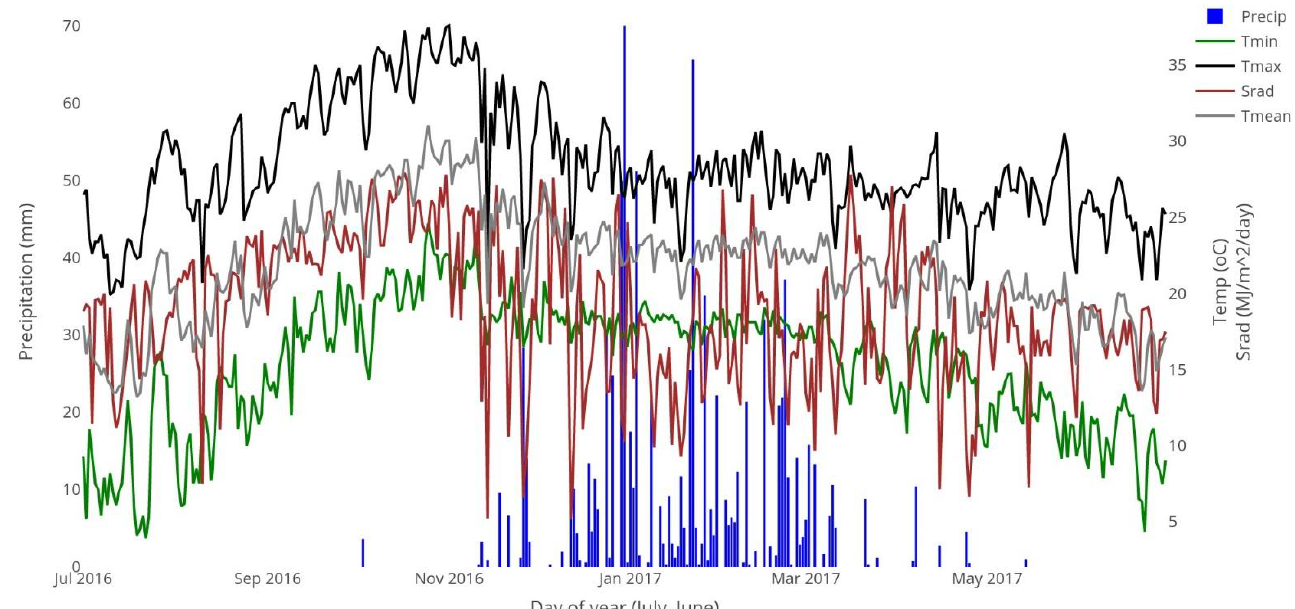
Figure 1. Daily weather data collected during the rainfed field experiment at Mt Makulu during the 2016/2017 season.